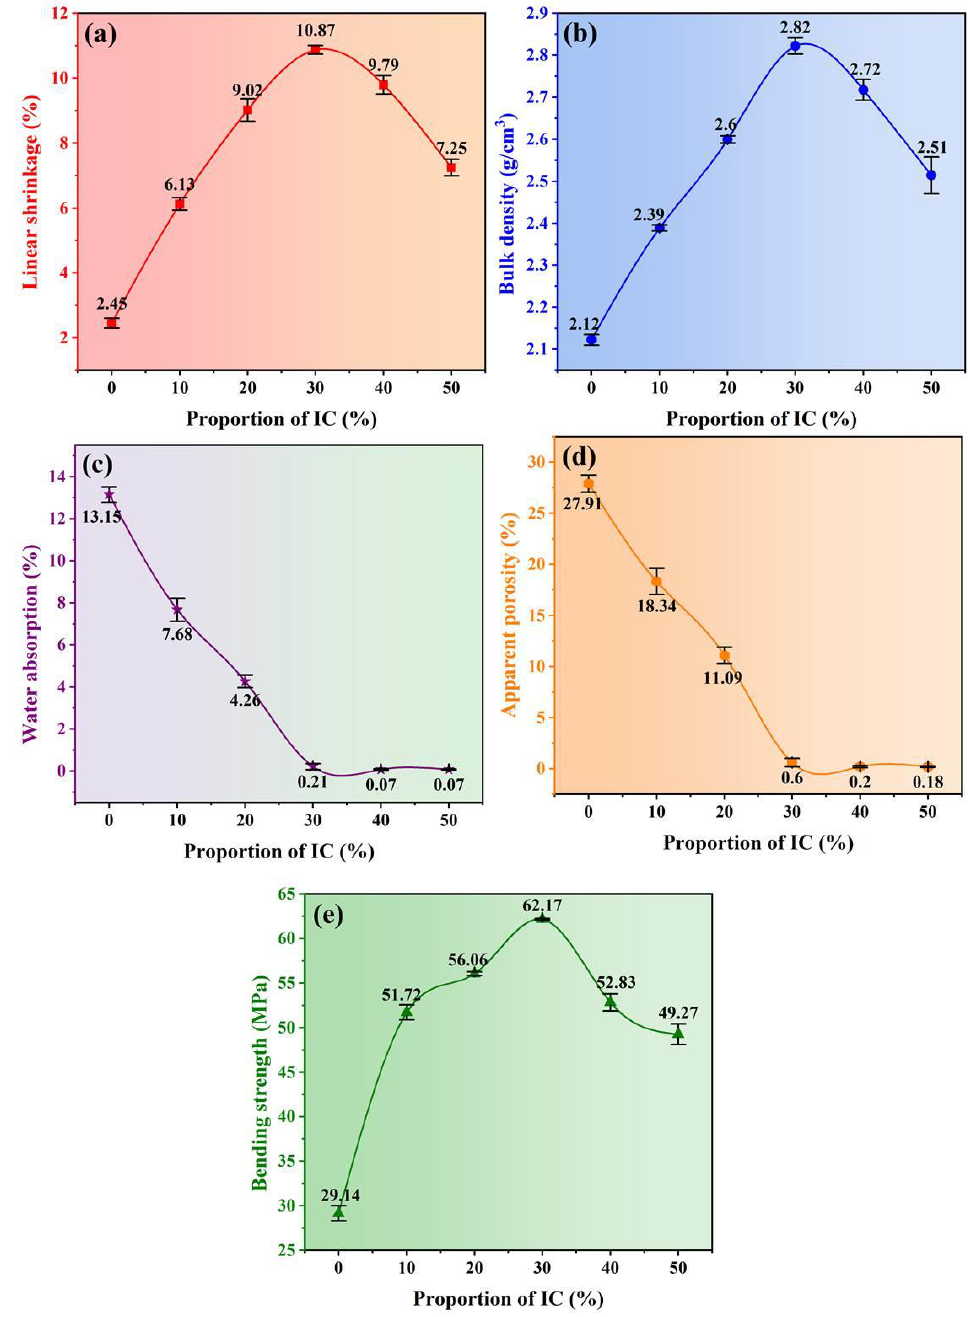
Figure 6. Physical properties of the ceramic samples. ( a ) linear shrinkage, ( b ) bulk density, ( c ) water absorption, ( d ) apparent porosity, and ( e ) bending strength.